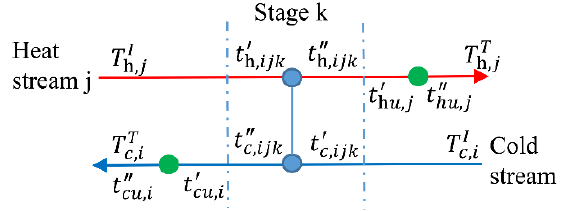
Figure 2. Heat transfer model for stream matching.